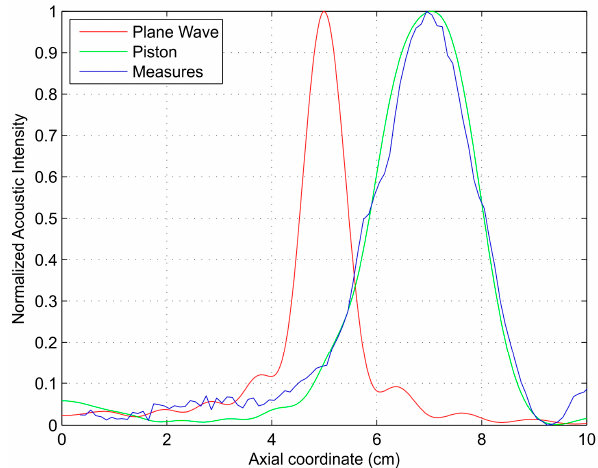
Figure 7. Normalized axial acoustic intensity against axial coordinate: simulated plane wave incidence model (red line), simulated piston model (green line), experimental measurements (blue line).